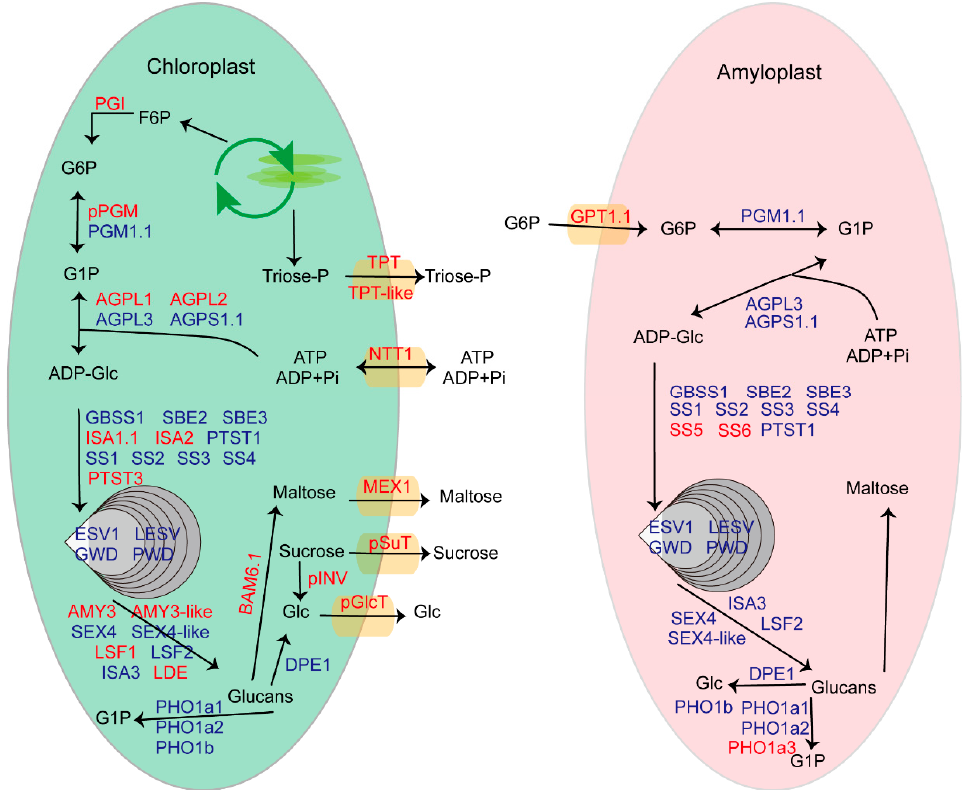
Figure 7. Proposed pathway of starch metabolism in different plastids. The proteins with red markers are unique in chloroplasts or amyloplasts, while these with blue markers are common in chloroplasts and amyloplasts. In the chloroplast, the Calvin–Benson cycle generates photoassimilates, including F6P and Triose-p. F6P can be converted to G1P in two subsequent steps catalyzed by PGI and PGM. G1P serves as the substrate for AGPase for starch biosynthesis. Triose-p can also be exported to the cytosol via the TPT. In the amyloplast, G6P synthesized via cytosolic PGM can be imported into the amyloplast by GPT. The imported G6P is then reconverted into G1P by plastidial PGM and as such can serve as a substrate for starch biosynthesis. F6P, Fructose-6-phosphate; Triose-p, triose-phosphate; TPT, triose-phosphate/phosphate translocator; PGI, phosphoglucoisomerase; G6P, glucose 6-phosphate; G1P, glucose 1-phosphate; PGM, phosphoglucomutase; AGPase, ADP-glucose pyrophosphorylase; SS, starch synthase; GBSS, granule-bound starch synthase; SBE, starch branching enzyme; GWD, glucan, water dikinase; PWD, phosphoglucan, water dikinase; BAM, beta-amylase; AMY, alpha-amylase; SEX4, starch excess 4; LSF, like starch-excess 4; DPE, disproportionating enzyme; PHO, alpha-glucan phosphorylase; GPT, glucose 6-phosphate/phosphate translocator; NTT, nucleotide translocator; pGlcT, plastidic glucose transporter; pSuT, plastidic sugar transporter; MEX, maltose transporter; ESV, early starvation; LESV, like ESV; PTST, protein targeting to starch; ISA, isoamylase-type starch debranching enzymes; SBE, starch branching enzyme; pINV, plastidic invertase. The protein accessions for the corresponding proteins are given in Supplementary Table